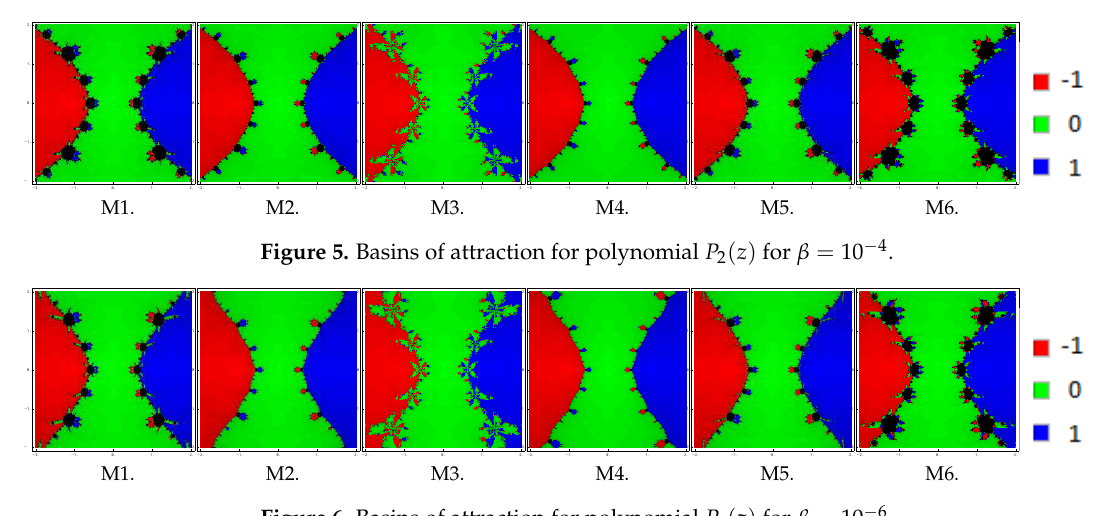
Figure 6. Basins of attraction for polynomial P 2 ( z ) for β = 10 − 6 .